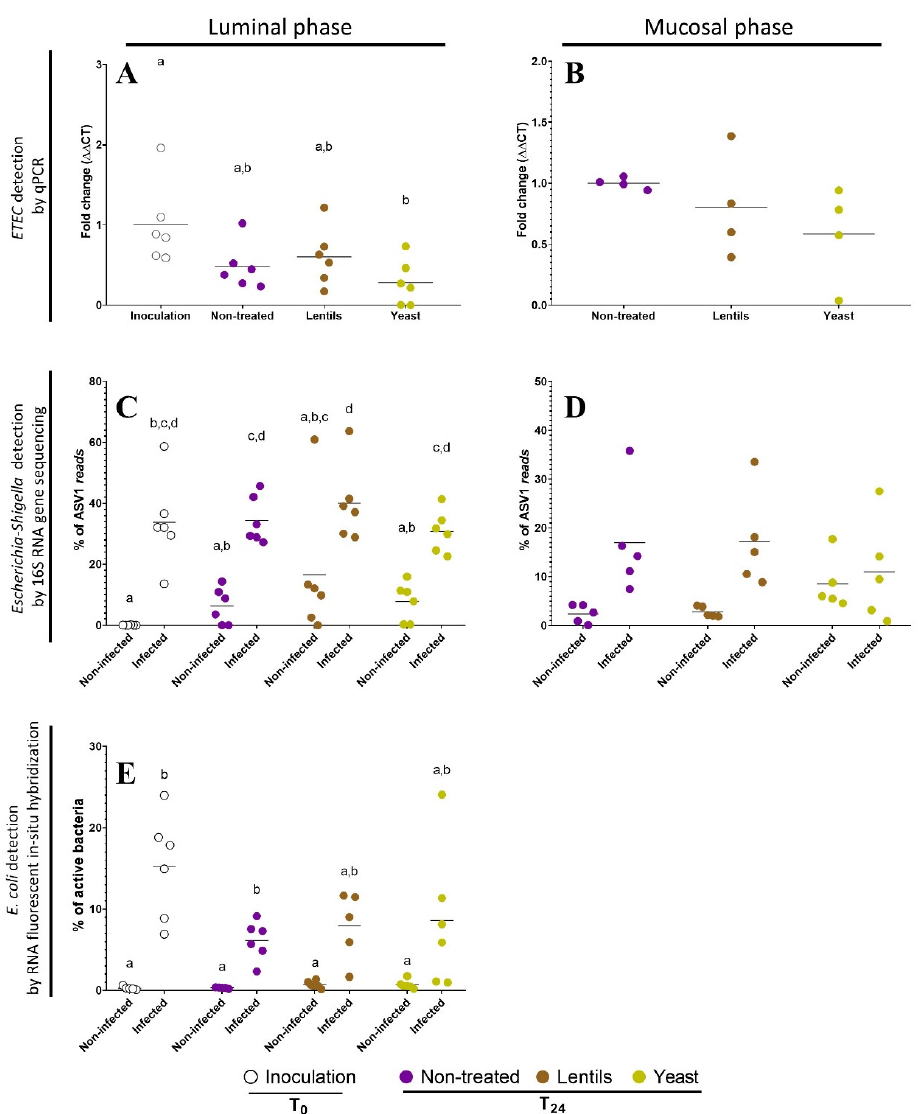
Figure 8. Impact of dietary-fiber-containing products on ETEC survival in in vitro batch colonic conditions. Penicillin bottles containing nutritive medium enriched in dietary-fiber-containing products were inoculated with feces from six healthy donors and then challenged with pre-digested ETEC strain H10407 at 10 8 CFU · mL − 1 . Control experiments were performed under non-treated and non-infected conditions. White, purple, brown, and yellow dots represent individual biological replicates at the beginning of the experiment after ETEC inoculation (Inoculation, T 0 ) or after 24 h of fermentation in the non-treated (Non-treated, T 24 ), lentil extract (Lentils, T 24 ), or specific yeast cell walls (Yeast, T 24 ) conditions, respectively. ( A , B ) qPCR detection of the H10407 ETEC strain among the total bacterial population is expressed as fold changes compared to inoculation T 0 (luminal phase) or non-treated T 24 (mucosal phase) conditions. ( C , D ) Percentages of ASV1 reads detected by 16S RNA gene amplicon sequencing in luminal and mucosal bacteria. ASV1 is the ASV with the highest read abundance in all samples and its reads were assigned to the Escherichia / Shigella genus and to Escherichia albertii / boydii / coli / dysenteriae / fergusonii / flexneri / marmotae / sonnei species. ( E ) Proportion of active E. coli in the total bacterial populations as detected by RNA fluorescent in situ hybridization. Bars represent the means of data ( n = 6). Results that are not significantly different from each other according to Tukey’s multiple comparisons tests are grouped under the same letter ( p < 0.05). ASV: amplicon sequence